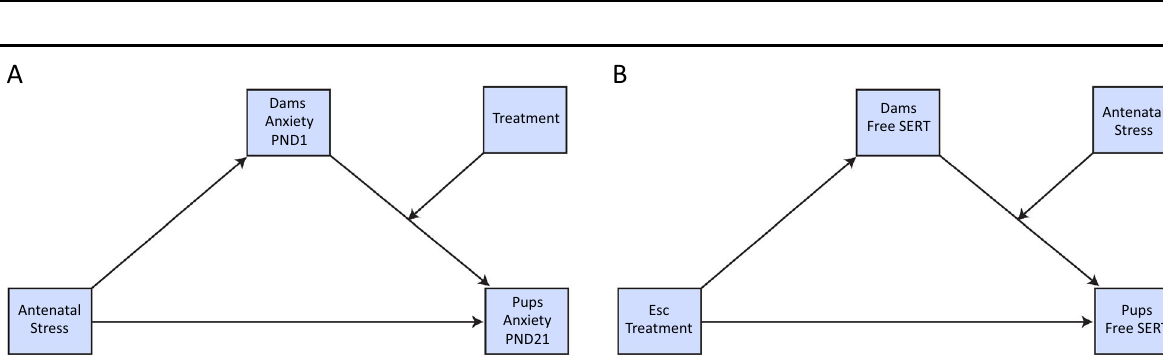
Fig. 1 Overview of the experimental design. Each column represents one experimental day. Created with BioRender.com. EPM elevated plus maze, GD gestational day, PND postnatal day, Serum biochemical assessments of escitalopram levels in the serum.